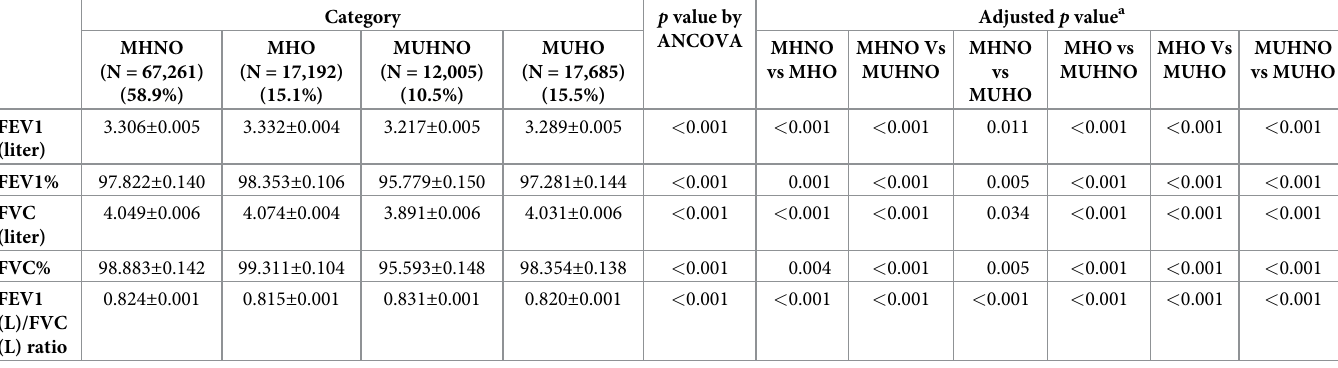
Table 2. Adjusted mean values of lung function parameters in the study group classified by metabolic health and obesity status.